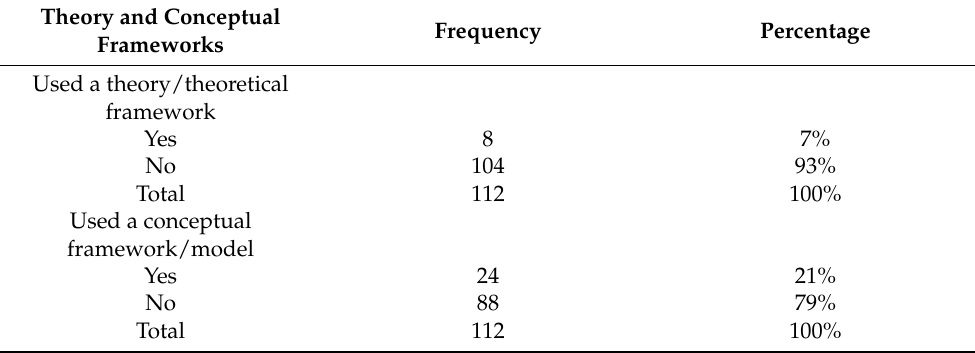
Table 1. Use of theories and conceptual frameworks in the construction robotics literature. Theory and